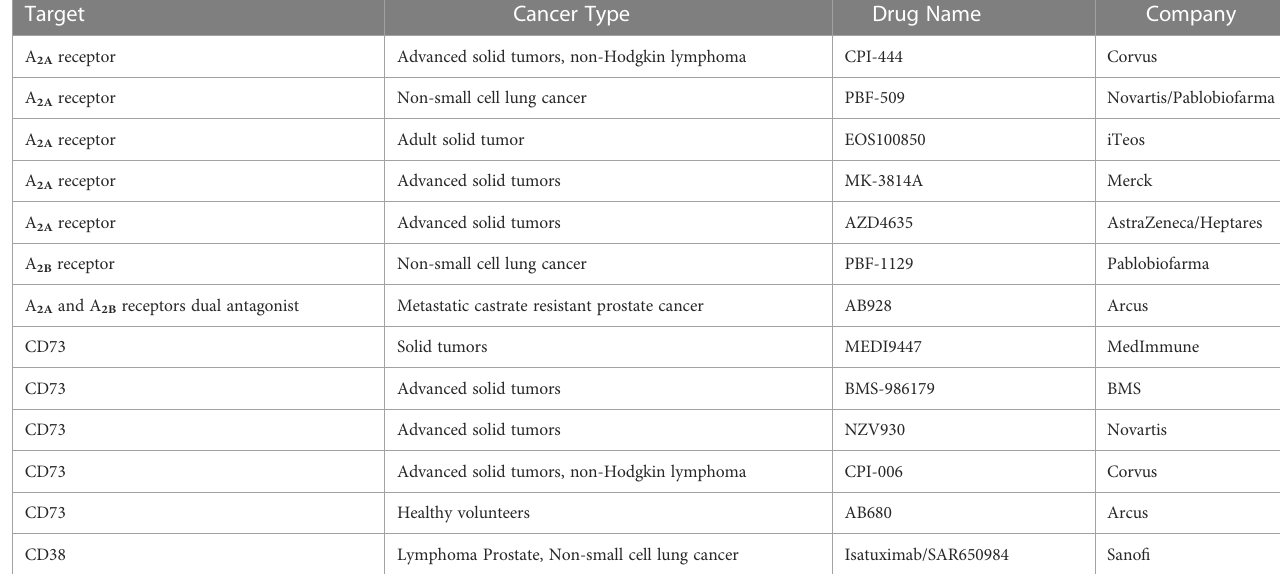
TABLE 1 Representative eADO pathway-targeting drugs which were involved in the most recent clinical trials.